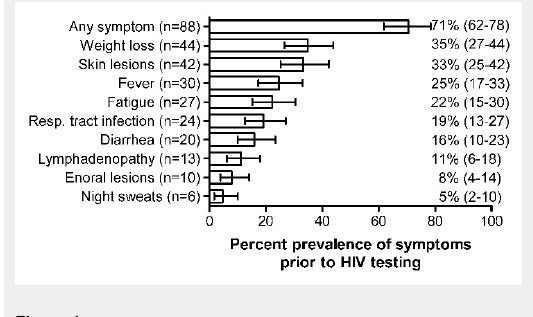
Prevalence of symptoms prior to the HIV test among the 125 late presenters. Error bars represent the 95% exact binomial confidence